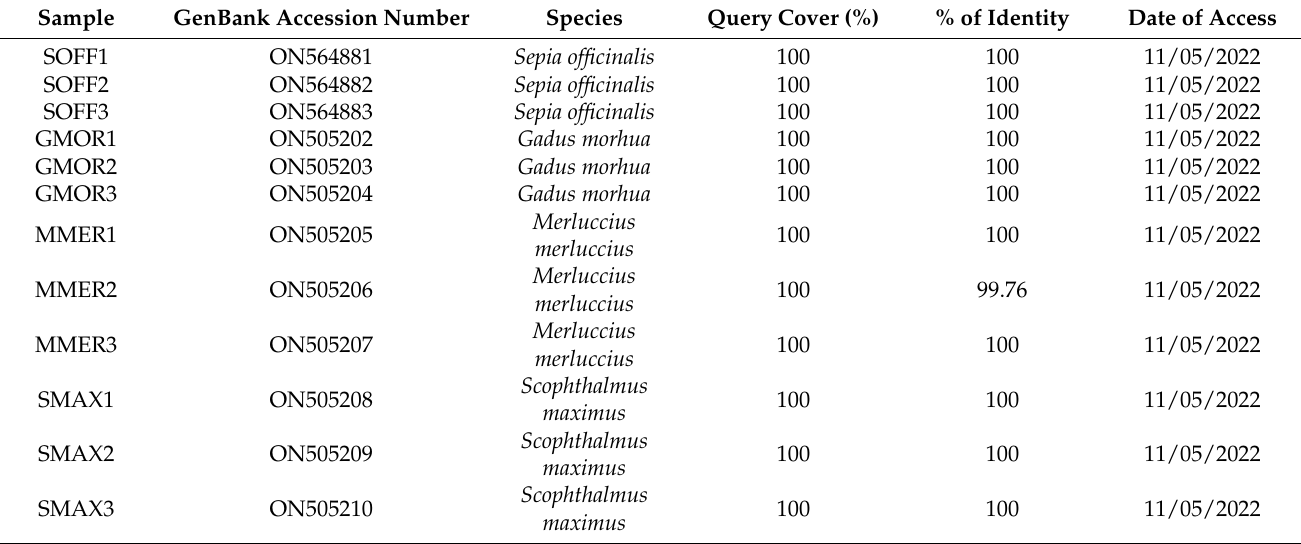
Table 4. Blast results for the authentication of the samples tested in this study.